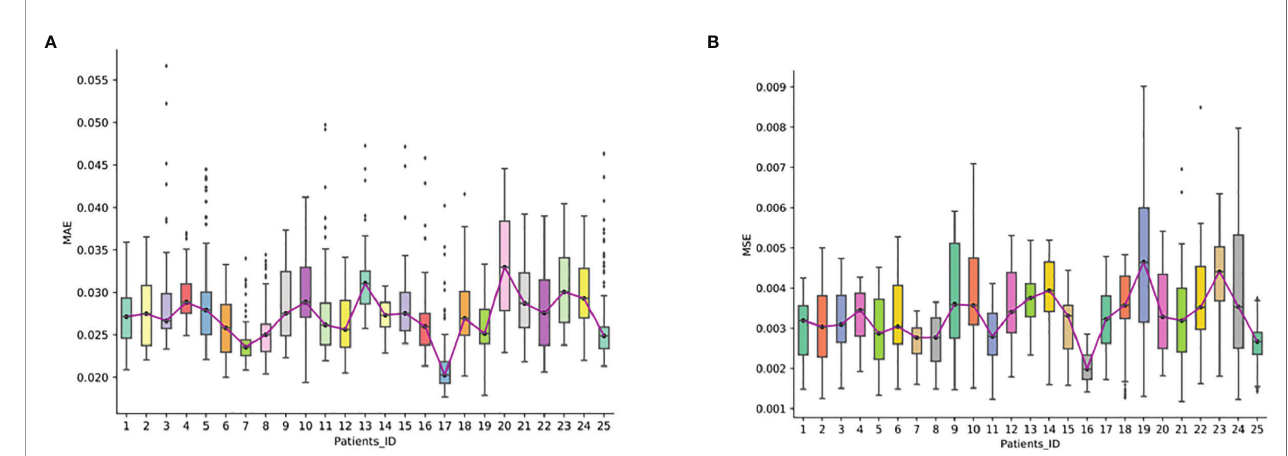
FIGURE 4 | The reconstruction error in synthesized FP-Dyn sequence images. The box plot displayed the data distribution of MAE and MSE of a reconstructed image of the 25 patients, and each of the box plots displayed the data distribution of one patient. (A) displayed the data distribution of MAE of a reconstructed image of the 25 patients, (B) displayed the data distribution of MAE and MSE of a reconstructed image of the 25